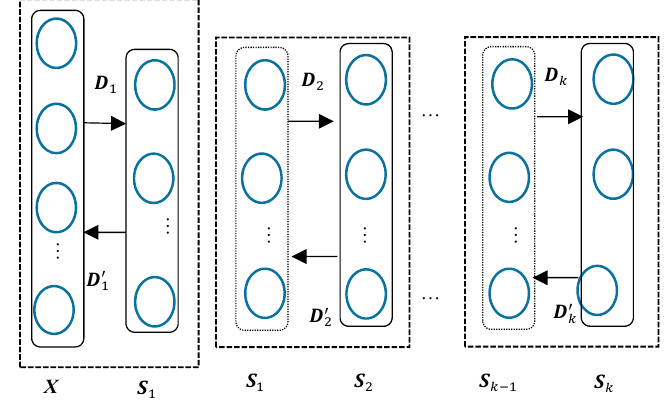
Figure 1. Scheme of stacked dictionary learning. Figure 4. Scheme of stacked dictionary